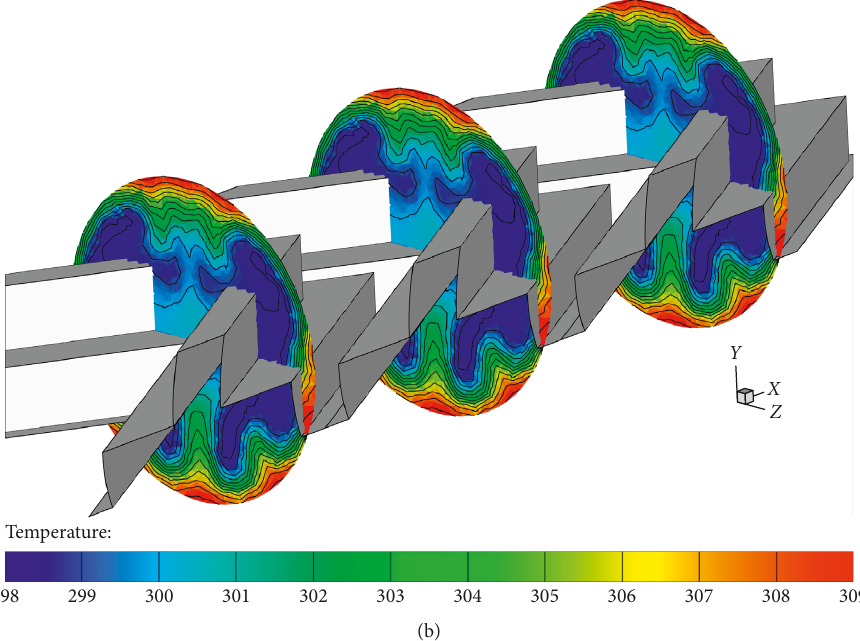
30 ° and Re 600 for (cid:28) (cid:28)